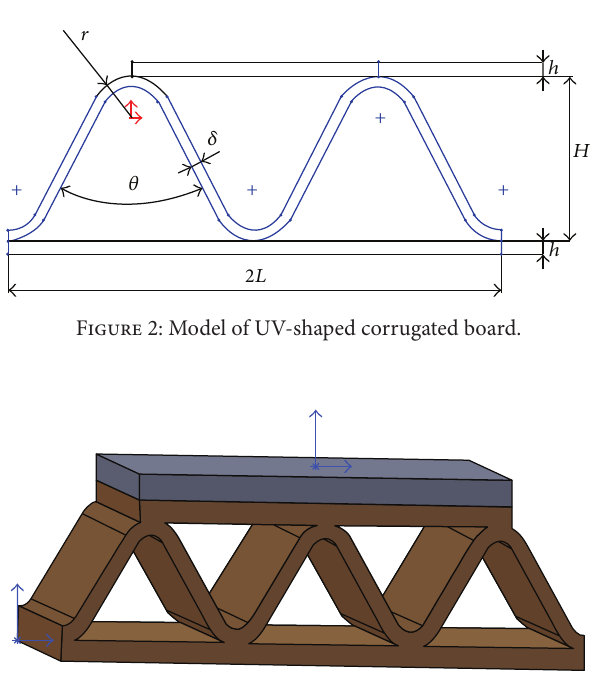
Figure 3: Improved model of UV-shaped corrugated board with rigid plate.